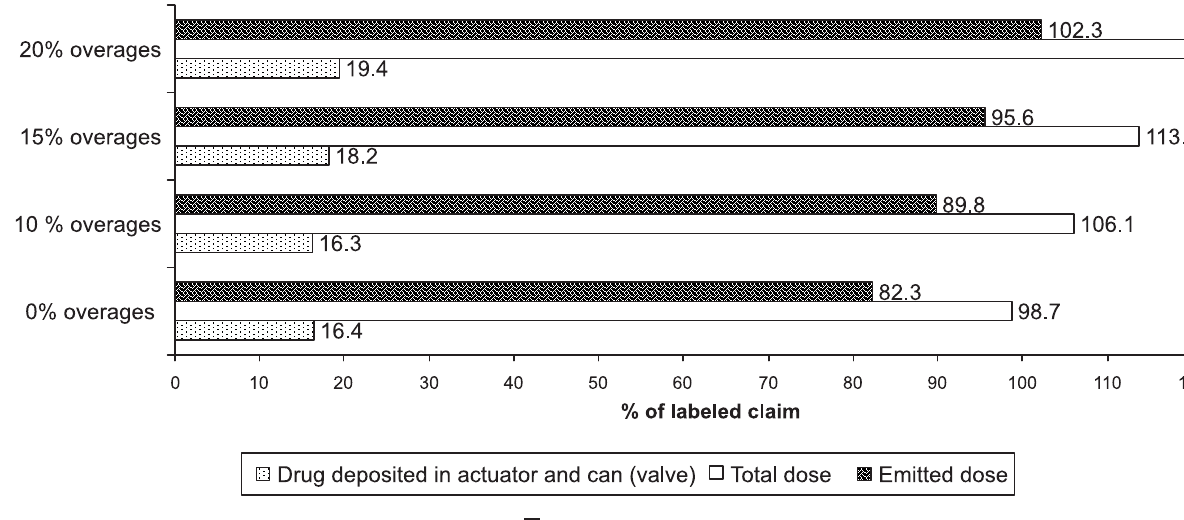
FIGURE 3 - Effect of overages on beclomethsaone dipropionate MDI.